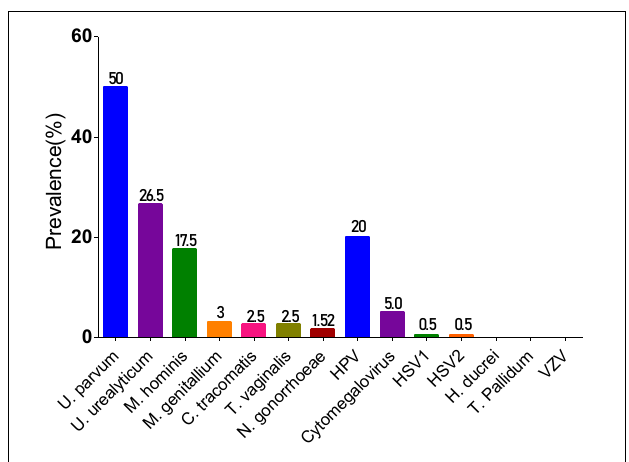
FIGURE 2 | Prevalence of germs responsible for STIs. The bars indicate the prevalence of each germ involved in STIs.